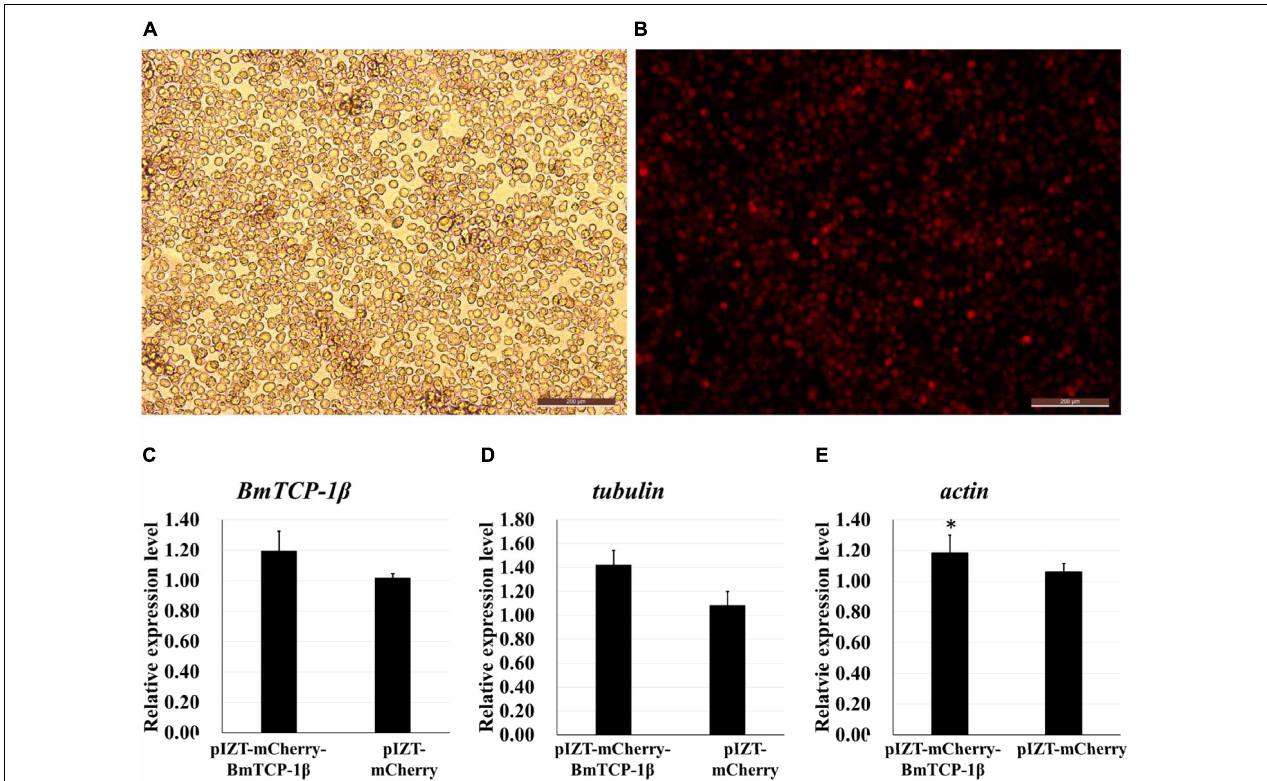
FIGURE 5 | Correlation analysis of BmTCP-1 β with selected cytoskeletal genes by overexpression of BmTCP-1 β in vitro . (A,B) , overexpression of BmTCP-1 β in BmN using the pIZT/V5-His-mCherry vector, scale bar = 200 µ m. (A) Trans (white), optical transmission. (B) Transfection of BmN cells with the pIZT/V5-His-mCherry-BmTCP-1 β vector, mCherry (red). (C–E) expression analysis of BmTCP-1 β , actin , and tubulin using RT-qPCR. One-way ANOVA with Tukey’s posttest was used. Data were analyzed as described above. Significant differences are indicated by asterisks ( p < 0.05).